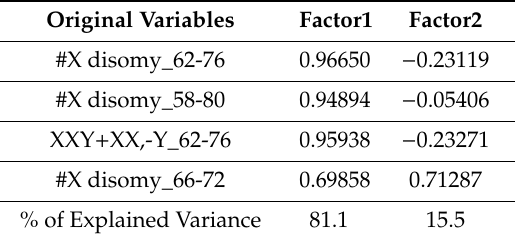
Table 2. Principal component analysis (PCA) loading pattern.